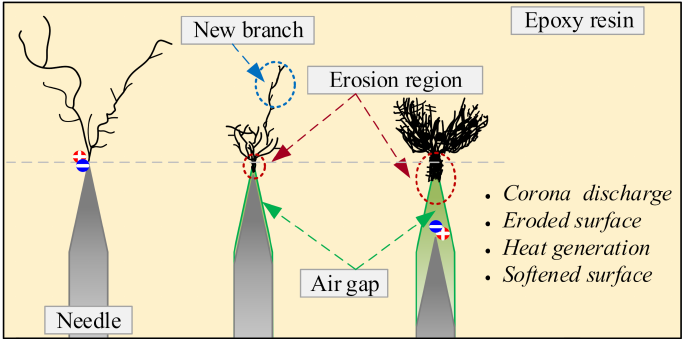
Figure 12. Schematic diagram of electrical treeing characteristics under high frequency bipolar square-wave voltage.